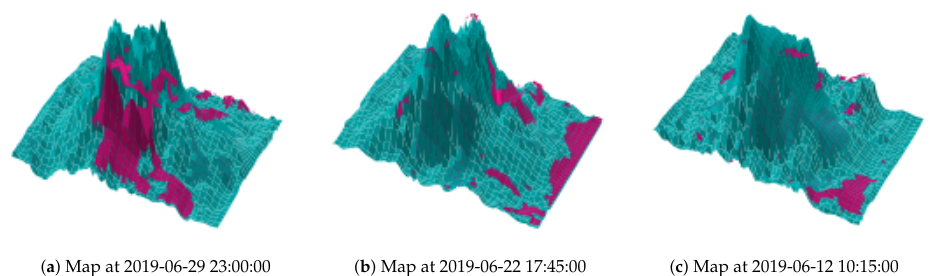
Figure 11. Forecast maps in which the basemap coincides with the global coordinates (latitude ± 90 degrees, longitude ± 180), and the height shows measured TEC values. The colors distinguish, (green), the regions of the GIM map where the prediction is within the ± sigma range, and in red the regions where the prediction is outside. Green areas : show the areas where the reference Forecast ref is included in Forecast Map ± Forecast Std . Red areas : areas where Forecast ref is outside the margin. Map